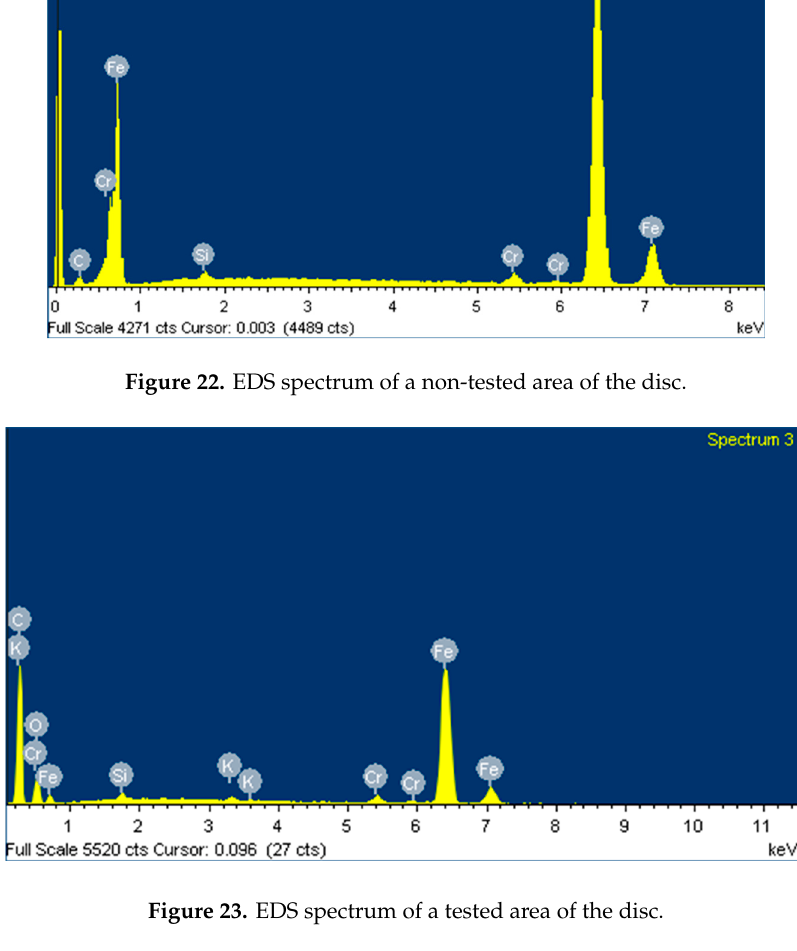
Figure 21. EDS spectrum of the marked area in Figure 19, where traces of ZrO 2 appear.